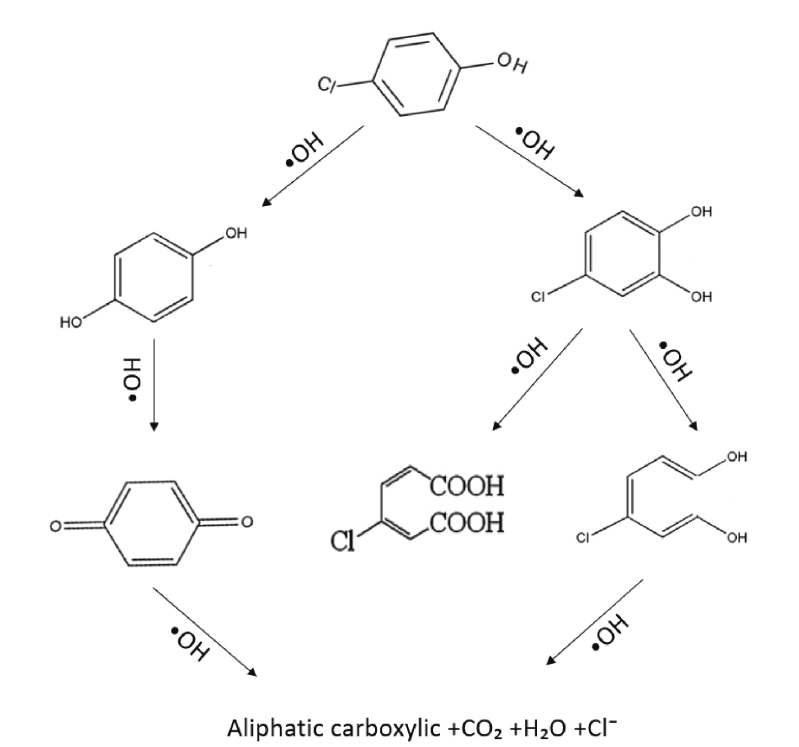
O @C process in selected 3 4